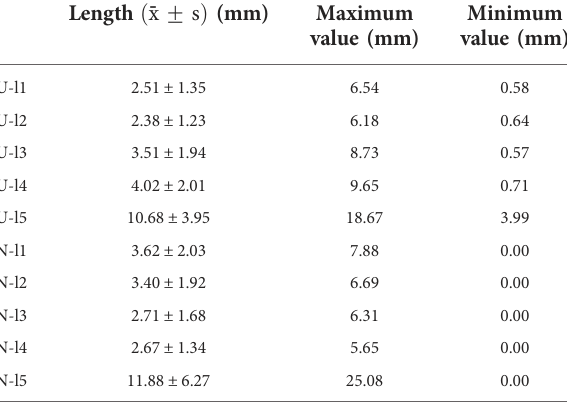
TABLE 2 Safety measurement of the cutting trace of the needle knife.